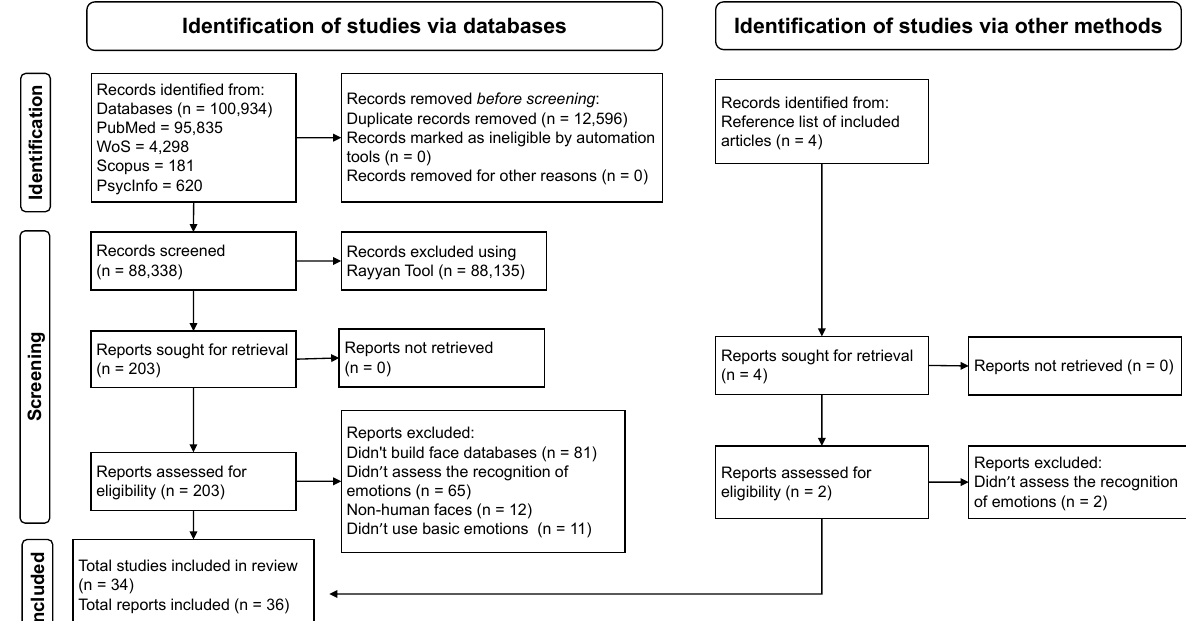
Figure 1. The article selection process according to the PRISMA initiative recommendations 17